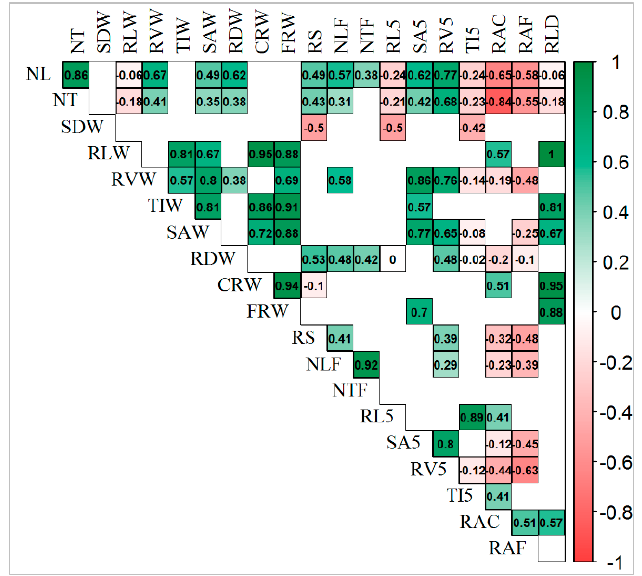
Figure 6. Positive significant correlation (in green) and negative significant correlation (in red) among all traits under control conditions. NL—number of leaves; NT—number of tillers; SDW—shoot dry weight; RVW—total root volume; RLW—sum of all root lengths; TIW—total number of tips; RDW—root dry weight; SAW—total root surface area, RLD—root length density, CRW—total number of crossings; FRW—total number of forks; RS—root shoot ratio; RL5—sum of root lengths in the first 5 cm below the ground; SA5—root surface area in the first 5 cm below the ground; TI5—number of tips in the first 5 cm below the ground; RV5—root volume in the first 5 cm below the ground; RAC—root angle of plants grown in greenhouse as control; RAD—root angle of plants grown in greenhouse under drought conditions; RAF—root angle of plants grown in the field.